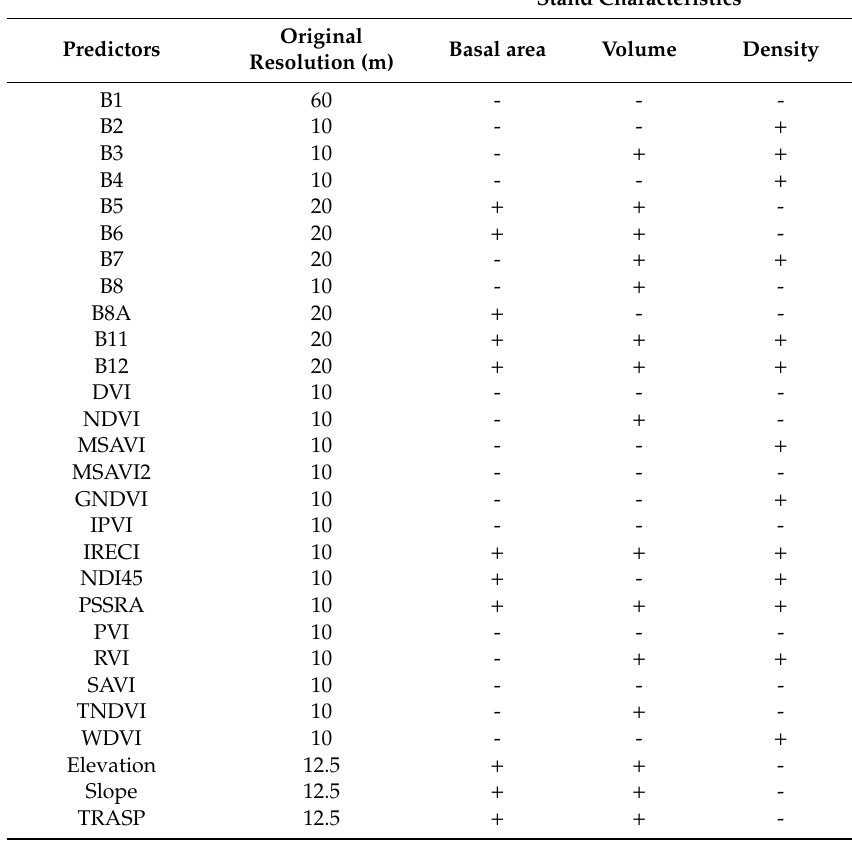
Table 4. Sentinel-2A and DEM predictors and variables used in forest stand characteristics